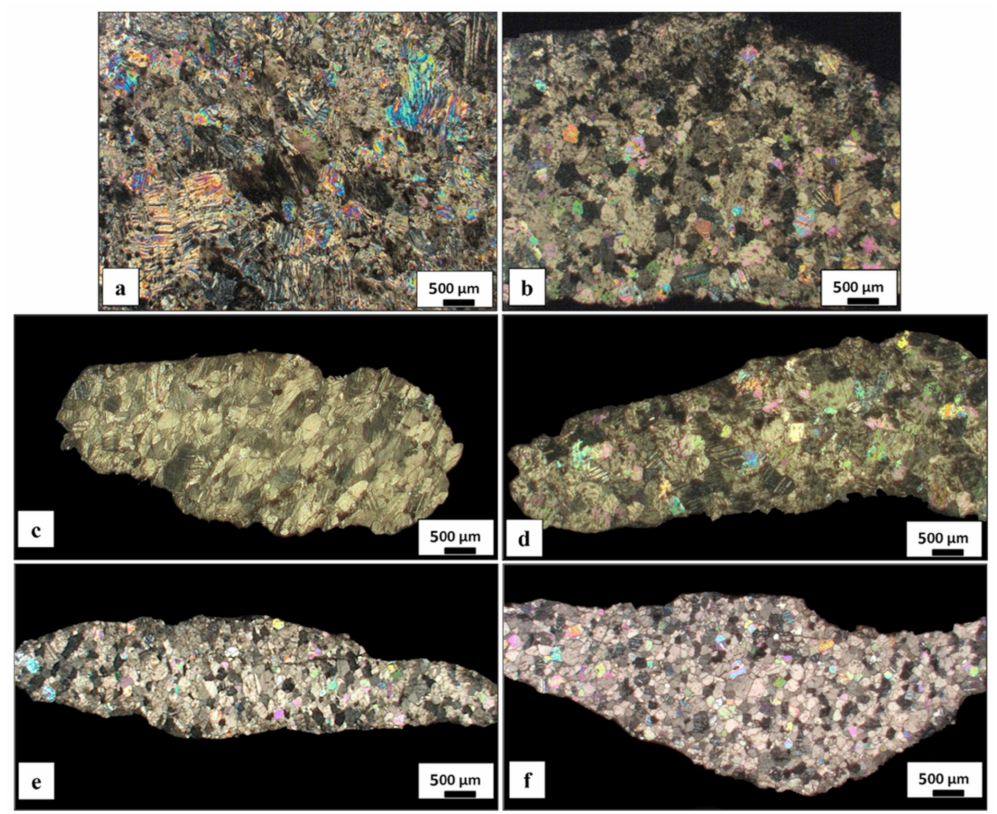
Figure 2. Microphotographs in POM (cross-polarized light view, Magnification 1 × ) showing the different textural features of the marbles constituting the “Madonna della Febbre” complex. ( a ) sample SD1; ( b ) sample SD2; ( c ) sample SD3; ( d ) sample SD4; ( e ) sample SD5; ( f ) sample